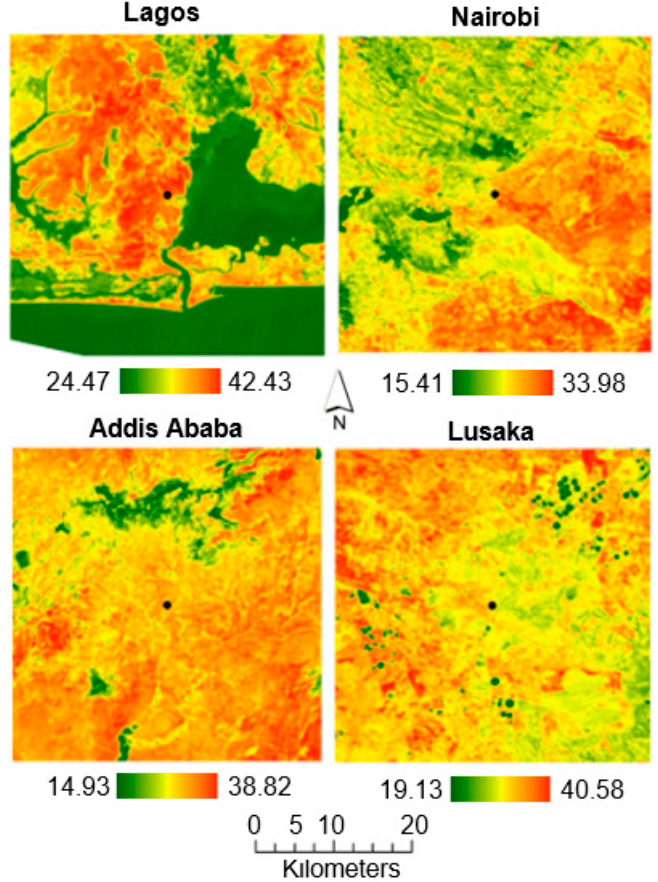
Figure 3. Land surface temperature (LST) distribution in the study areas: Lagos, Nairobi, Addis Ababa and Lusaka.